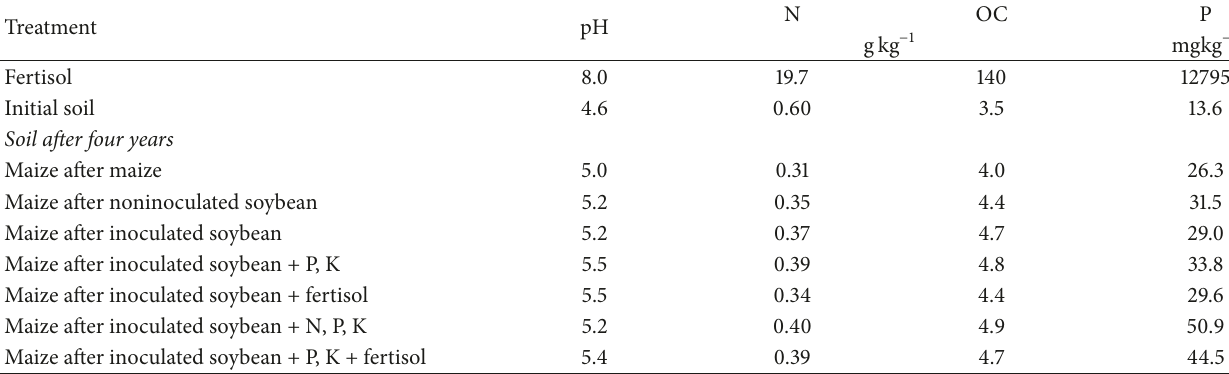
Table 1: Chemical composition of fertisol, initial soil, and the soils after four years of treatment. Treatment pH